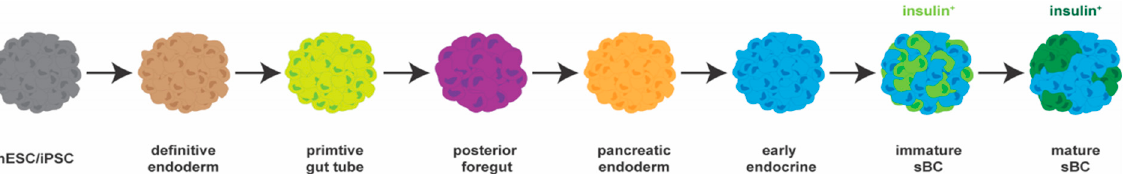
Figure 2. Stem cell-derived beta-like cell differentiation protocols recapitulate developmental cues. Human pluripotent